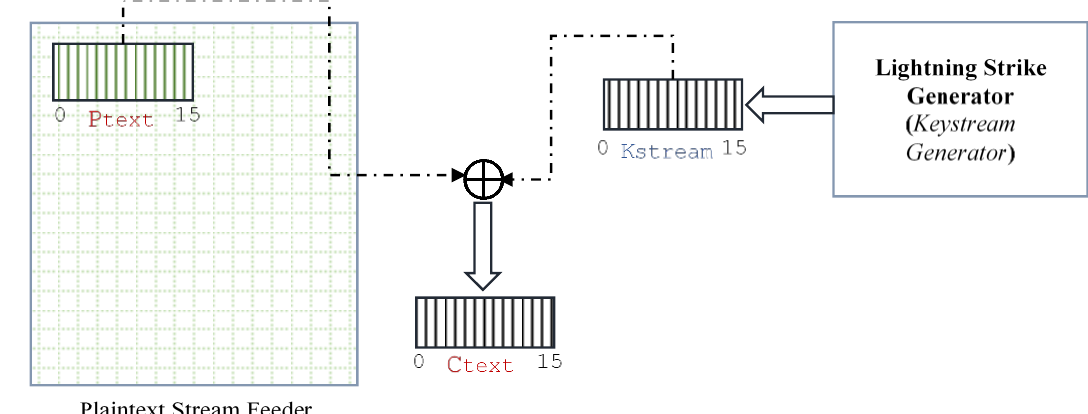
Figure 6. Plaintext Encryption. Algorithm 3 Encryption